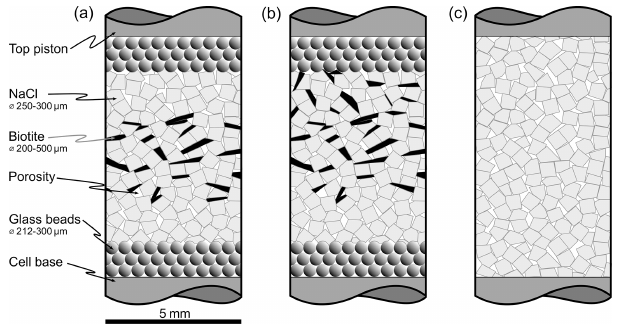
Figure 1. Schematic sketches of sample configurations of (a) the NaCl–biotite–NaCl sample (SBS), (b) the NaCl–biotite sample (SB) and (c) the pure NaCl reference sample (S) before deforma- tion. Different shades of grey depict the single components but are not related to their appearance in the tomography scans. White an- gular patches represent the brine saturated pore space with arbitrary distribution of shape and size, light grey angular to square objects are cubic grains of analytical-grade NaCl with a sieved grain size of 250–300µm, and black elongated angular shapes are biotite grains of 200–500µm size. At the top and bottom of the samples in pan- els (a) and (b) , dark grey circles describe acid-washed glass beads of 212–300µm diameter, which were inserted as a chemically inert layer. The original samples have a diameter of 5mm; note that the sketches are not to